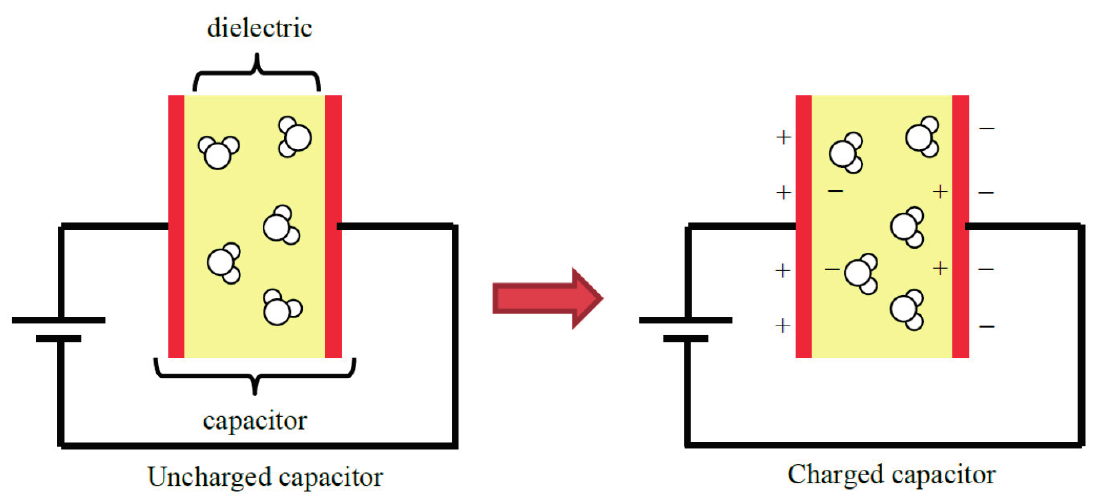
Figure 3. Polarization of the dielectric when under an electrical